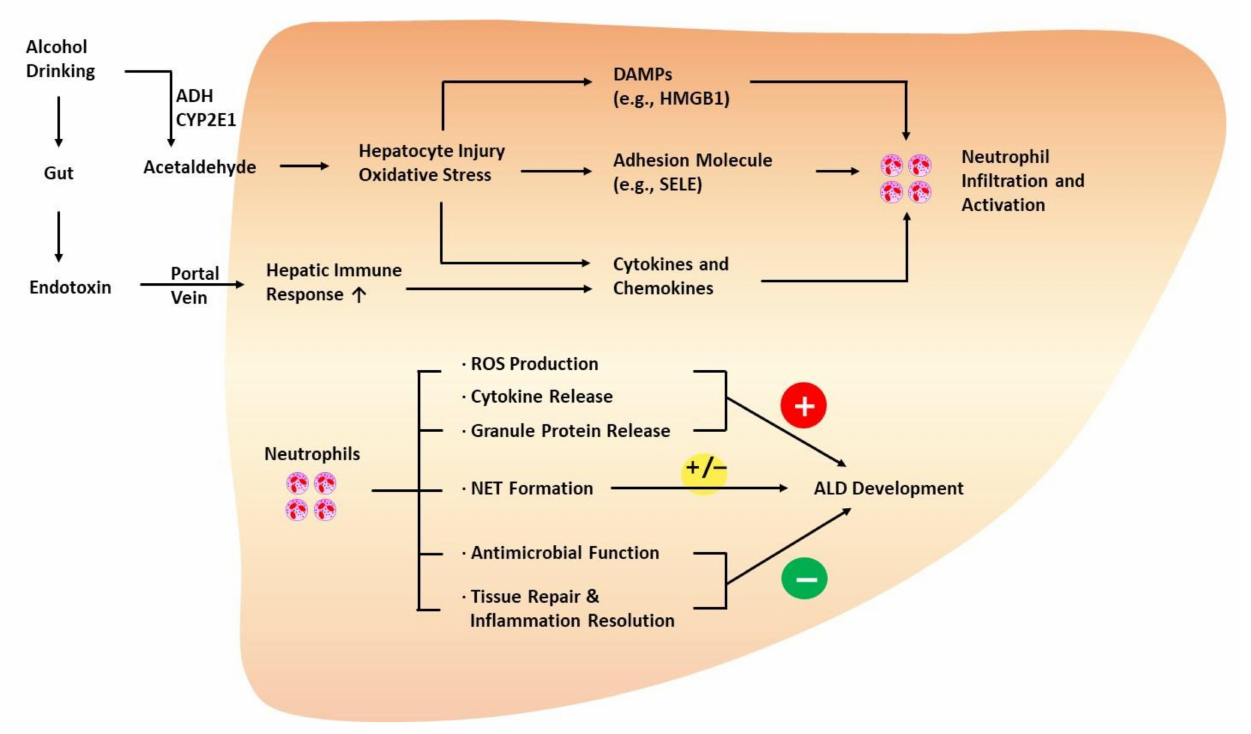
Figure 2. Role of neutrophils in the development of ALD. Injured hepatocytes with oxidative stress promote neutrophil infiltration and activation via the release of DAMPs, cytokines, and chemokines. In addition, endothelial cells upregulate adhesion molecules, such as SELE, to facilitate hepatic neutrophil infiltration. Neutrophils play both protective and detrimental roles during ALD progression. Generally, neutrophils are known to exacerbate ALD via oxidative burst, ROS production, cytokine release, and the release of granule proteins (e.g., myeloperoxidase). However, neutrophils also express antimicrobial factors, such as lipocalin 2, and play a crucial role in affording protection against infection in patients with ALD. Neutrophils are also involved in tissue repair by releasing HGF and inflammation resolution, delaying the progression of ALD. NETs not only augment hepatocyte injury but also mediate the antimicrobial function of neutrophils. HGF, hepatocyte growth factor; HMGB1, high-mobility group box 1 protein; NET, neutrophil extracellular trap; SELE,